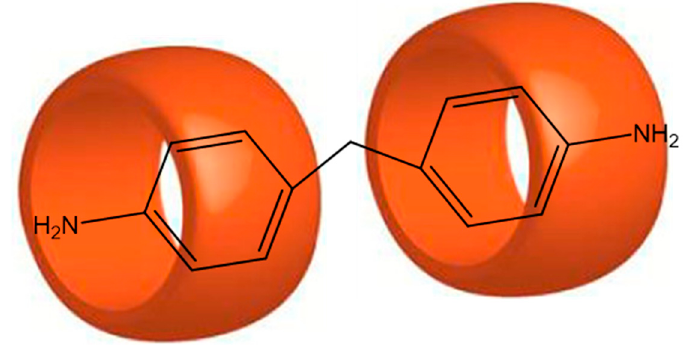
Figure 9. Model of interaction between Q[7] and MDA.